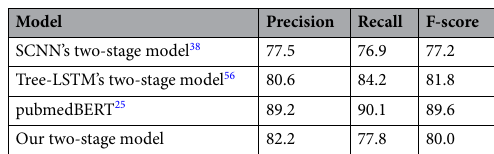
Table 1. Performance evaluation for relation detection using DDIE2013 and dataset.